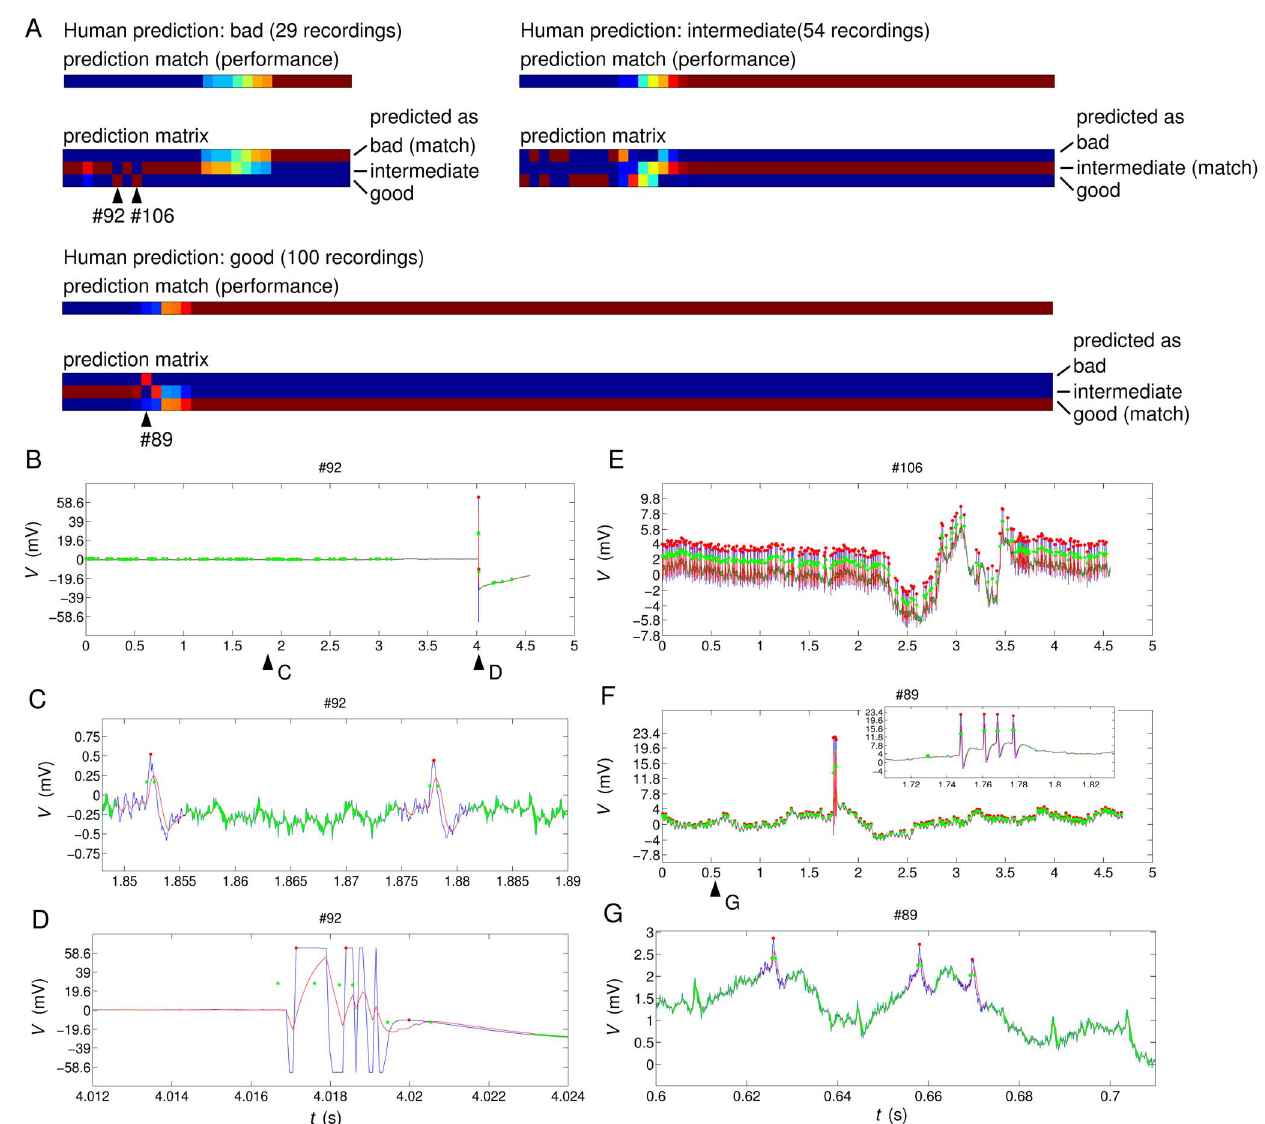
Figure 6. Comparison of individual predictions of expert 1 and the machine learning classifier 6–2133. (The feature sets are labeled by their size, here 6 features, and then enumerated from 0 to N–1, where N is the maximal number of feature choices for the given size. The feature set used here is number 2133 out of a total of 8008 possible choices.) for data set 1. A) Match of the predictions of human expert and machine. The recordings are ordered from the recording with the worst mismatch between expert 1 and the 50 times repeated 10-fold crossvalidation with 6–2133 on the left to the ones with the least mismatch on the right. The colour represents the percentage of crossvalidation runs where machine and human prediction match scaling from blue (0% match) to dark red (100% match). The 3-row prediction matrices show the details of how often individual recordings (x-axis) were recognised as the three classes (y-axis). The colour scale is the same as for the performance. B)–G) Raw data plots of the three most problematic recordings, where blue lines are the voltage data, red lines the filtered voltage data, red dots the top of detected spikes, and green dots the half-height of spikes, shown at spike time + / 2 half spike width. Panels C and D are detailed plots of two relevant regions of recording # 92 as indicated by arrowheads in B. The inset in F and panel G are details of two relevant regions of recording # 89 as indicated by arrowheads in